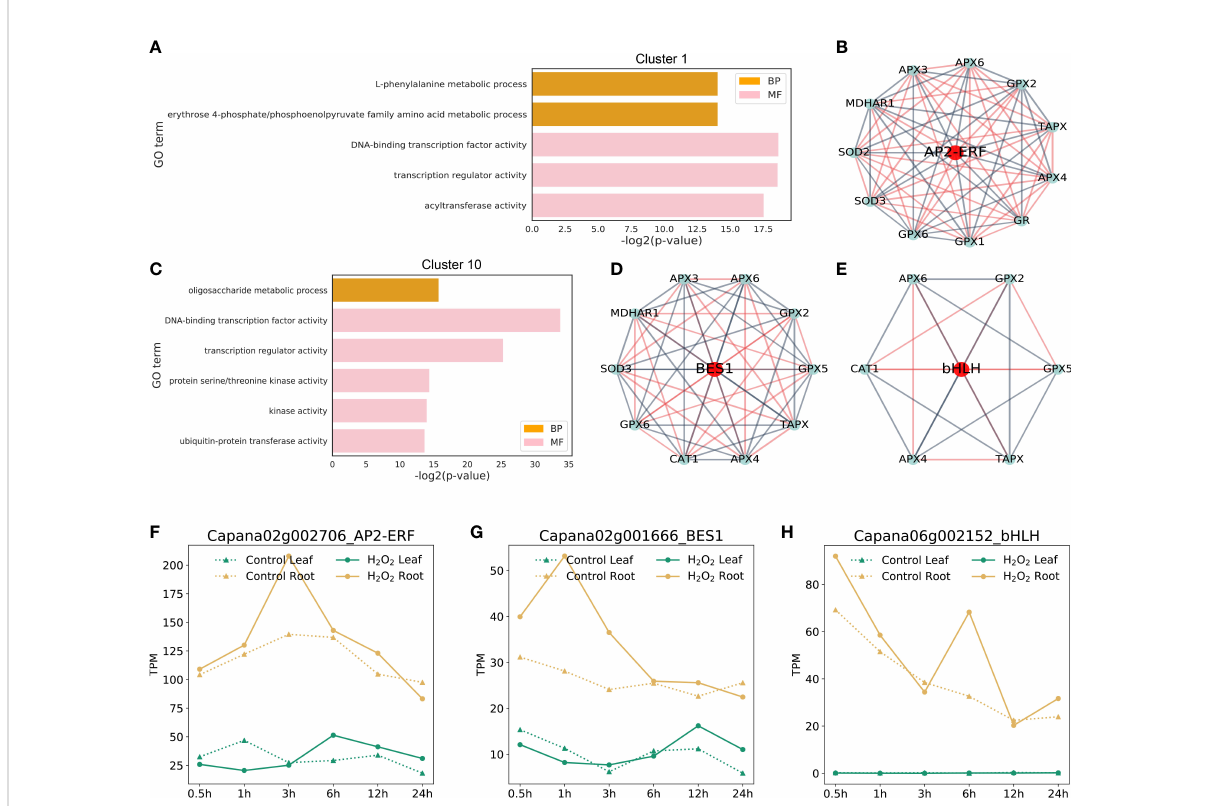
FIGURE 7 Important clusters in GO enrichment and TF networks. (A, C) : GO terms of the identi fi ed DEGs from Cluster 1 and Cluster 10 (FDR < 0.01)). The complete lists of cluster genes and GO terms from the enrichment analysis are shown in Supplementary Tables S9, S10. (B, D, E) : The transcriptional factors that co-expressed with ROS-scavenging genes were identi fi ed using the constructed network. (F – H) : Expression pro fi les of the three candidate transcription factors at different time points in control and H 2 O 2 stress in leaves and